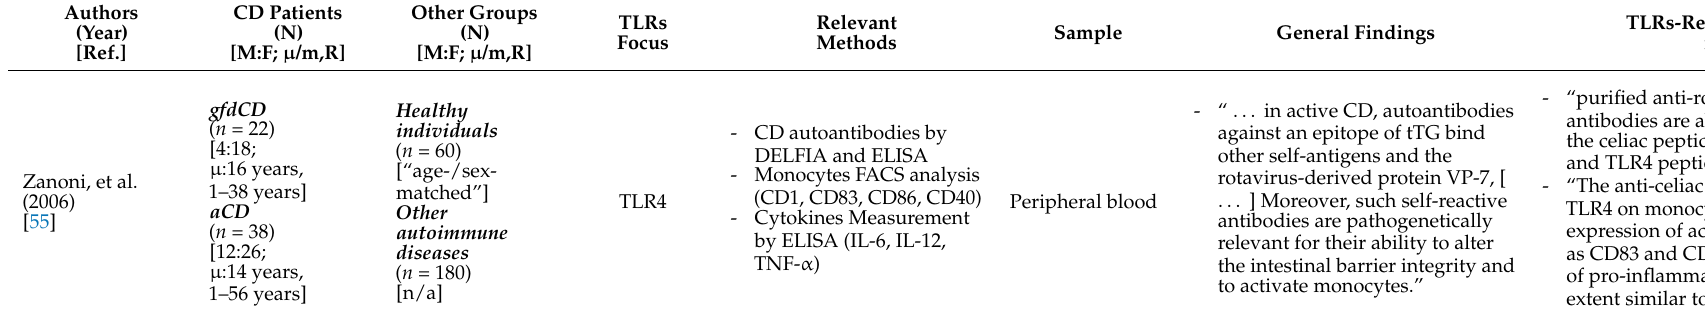
Table 4. Clinical studies assessing TLRs in patients affected with Celiac